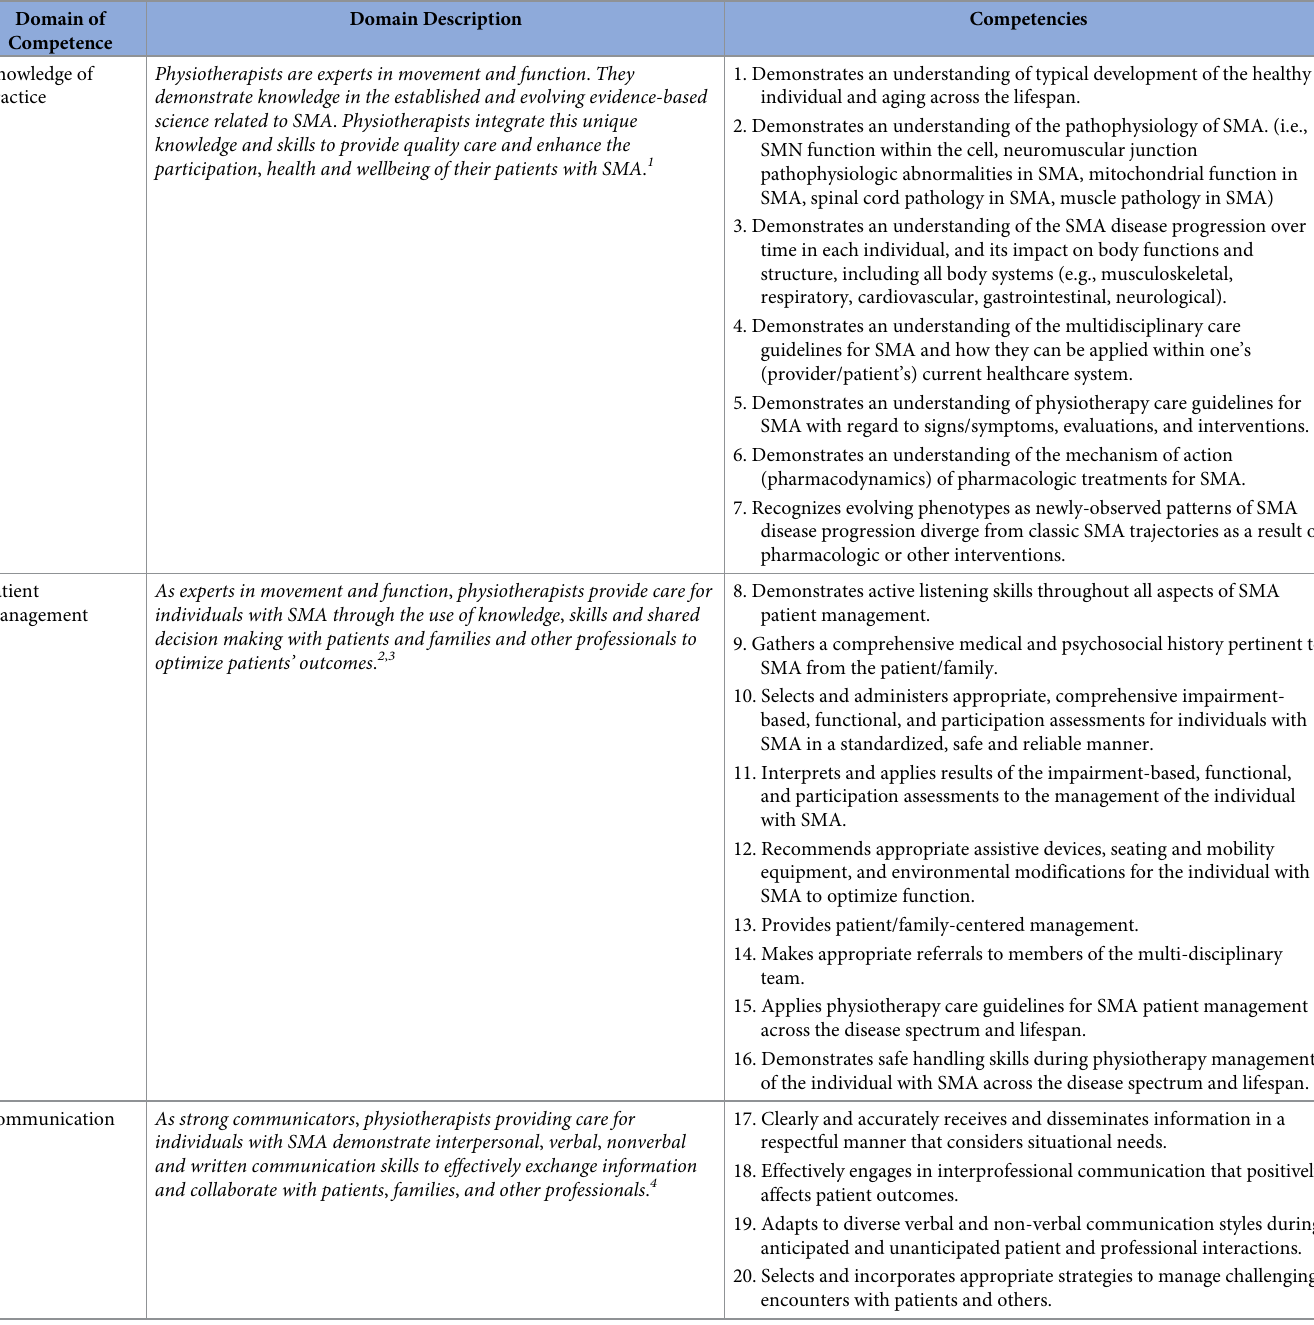
Table 4. Essential competencies for physical therapists working with individuals with spinal muscular atrophy organized within six domains. Domain of